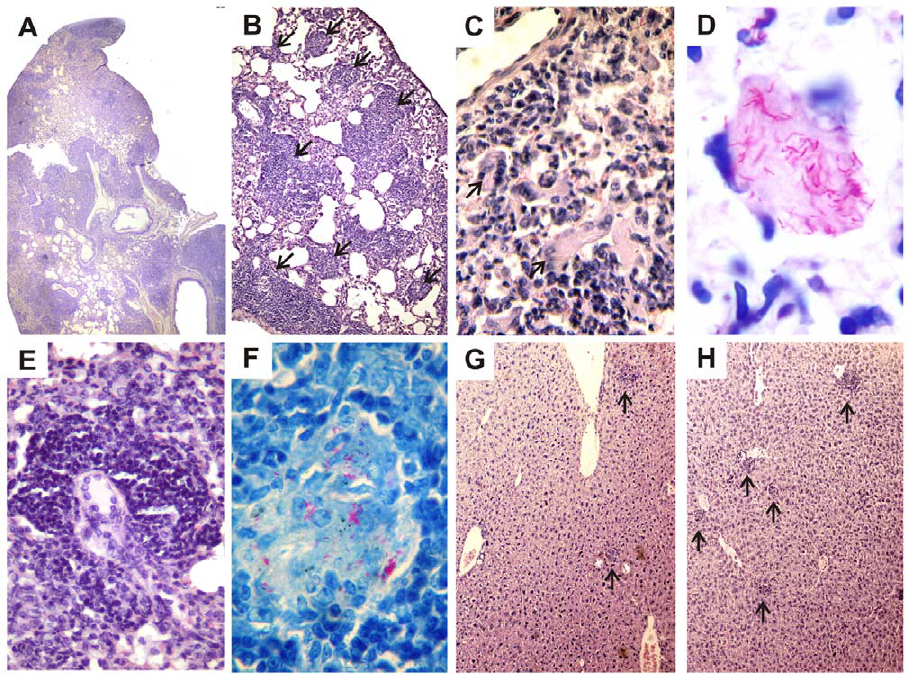
Figure 4. Lung, liver and spleen histopathology of C57BL/6 WT and GKO mice infected with the P104 or H27 M.avium strains. Representative lung histopathology at 60 days after P104 strain challenge in the WT (B) and GKO (A, C–E) mice and spleen (F) of the GKO mice. Lung presented parenchyma consolidation by epithelioid granulomatous infiltration (A), multifocal lesions with typical granuloma (B - arrows), cellular infiltration containing multinucleated giant cells (C - arrows) with intracellular fuchsinophilic acid-fast bacilli (D); granuloma containing multinucleated giant cells (E) and presence of BAAR inside the intrafollicular granuloma in spleen (F). Representative liver histopathology at 90 days after the challenge of the WT mice with H27 (G) and P104 (H) strains. The tissue samples were stained with H&E (A, B, C, E, G and H) or by Ziehl- Neelsen method (D and F). Total original magnification: A (4x); B, G, H (10x); C, E (20x); F (40x); D (100x).